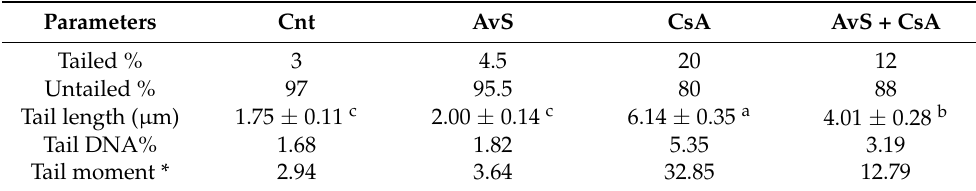
Table 5. Effect of AvS ameliorated hepatic cells’ DNA damage induced by CsA, as detected by the comet